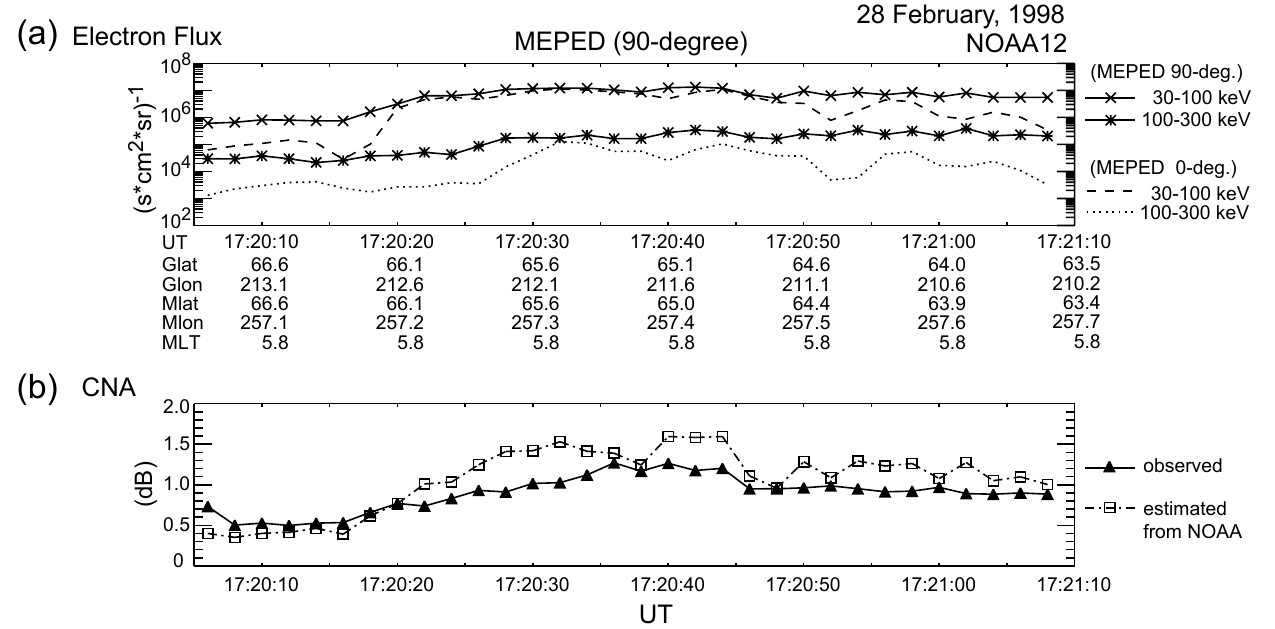
Fig. 5. (a) Trapped electron flux measured by the MEPED-90 ◦ for the same event as shown in Fig. 2. The dashed (30–100keV) and dotted (100–300keV) lines are the precipitating electron fluxes measured by the MEPED-0 ◦ . (b) The CNA observed with the imaging riometer (solid triangles with the solid line) and CNA estimated using the trapped electron flux measured by the MEPED-90 ◦ (open squares with the dashed-and-dotted line). The pitch angle distribution is assumed to be isotropic for the calculation.